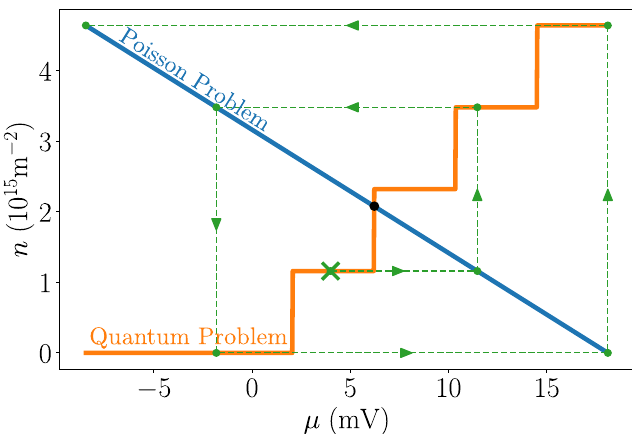
Figure 2: Zero-dimensional model for the self-consistent quantum electrostatic prob- lem in the planar capacitor 0D geometry of Fig. 1(a). Orange line: solution of the quantum problem Eq. (11). Blue line: solution of the Poisson problem Eq. (8). Green arrows: example of a simple iterative solution of the problem which fails to converge. Geometric capacitance C = 0.028 F / m 2 , dopant density n netic field B = 2.4